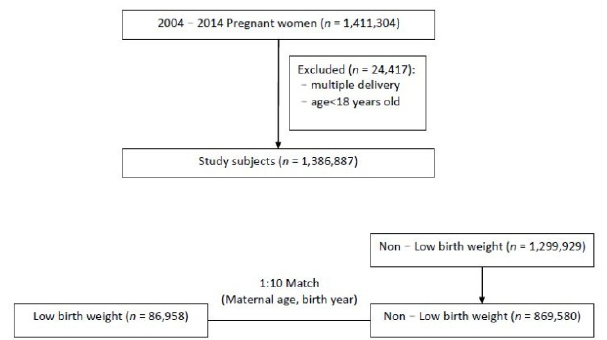
Figure 1. Flowchart illustrating the study design.